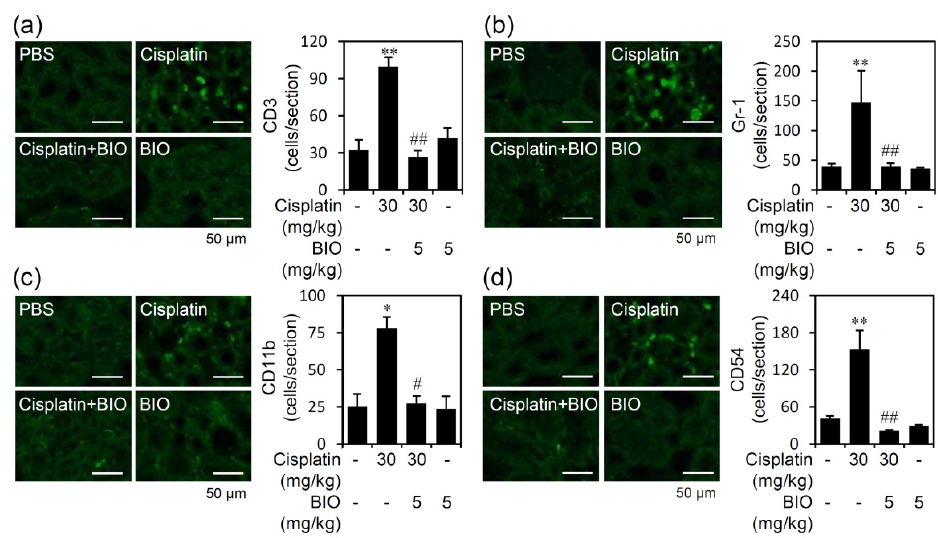
Figure 4. Inhibiting GSK-3 reduces cisplatin-induced renal immune cell infiltration. Male C57BL/6 mice ( n = 3) were preinjected i.p. with the GSK-3 inhibitor BIO (5 mg/kg) for 0.5 h followed by cisplatin (30 mg/kg) for 24 h. Immunohistochemical staining for ( a ) CD3, ( b ) Gr-1, ( c ) CD11b, and ( d ) CD54 (as shown by the number of positive cells per section). For all images, a representative image set obtained from three mice is shown (scale bar = 50 µ m). Quantified data are the mean ± SD. * p < 0.05 and ** p < 0.01 compared with untreated. # p < 0.05 and ## p < 0.01 compared with cisplatin.